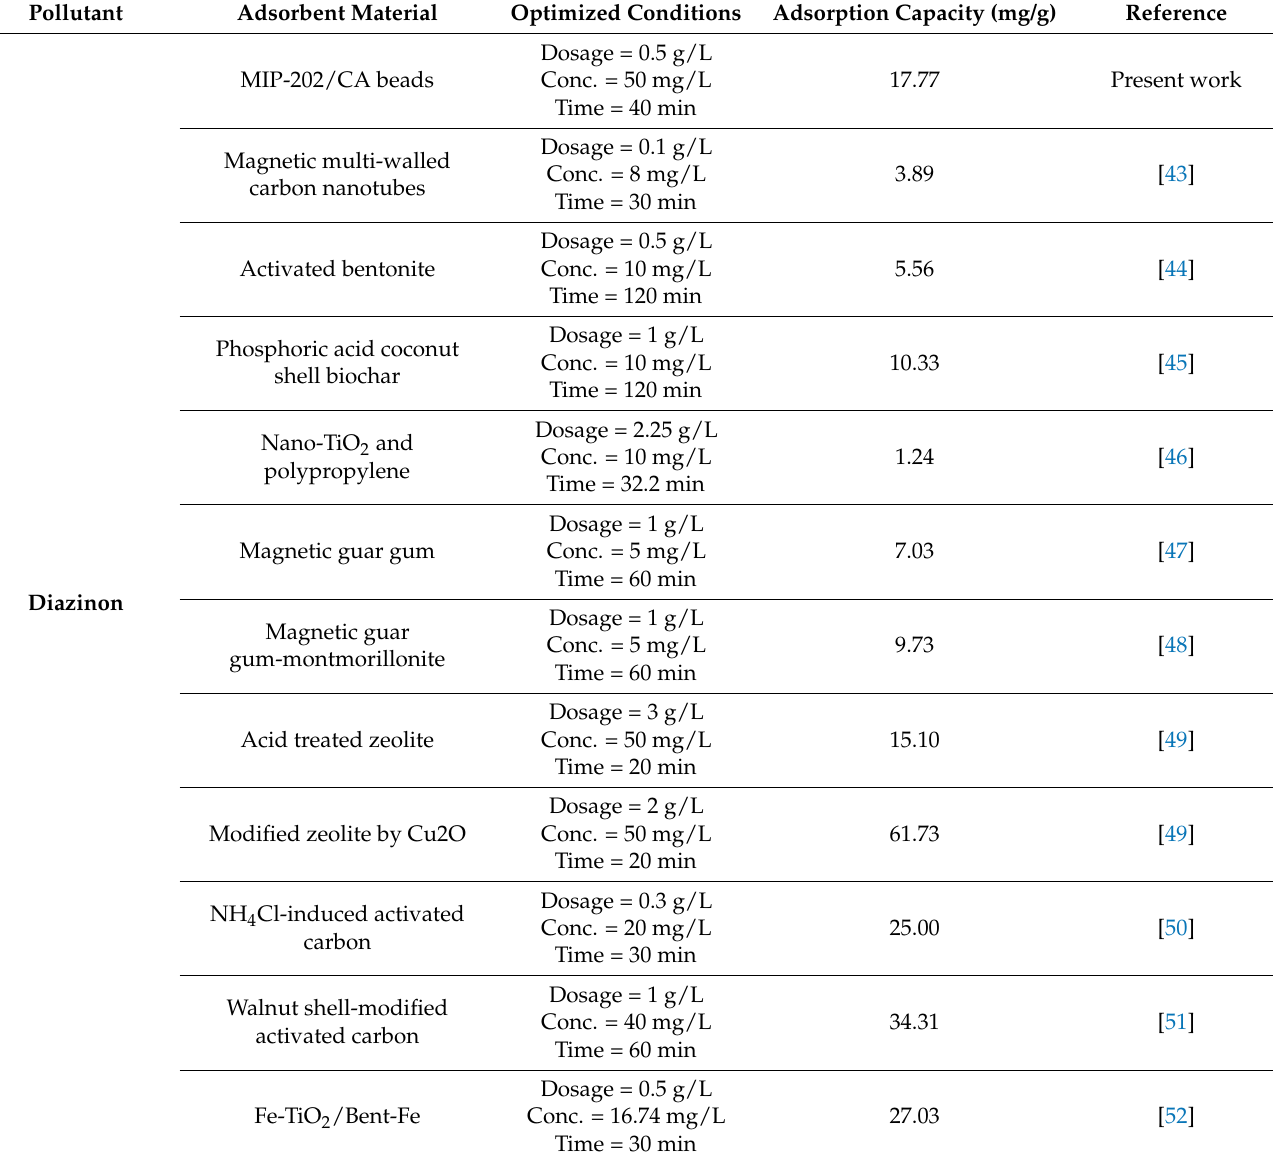
Table 3. Comparison of mono-layer adsorption capacities of diazinon via different adsorbent nanomaterials.